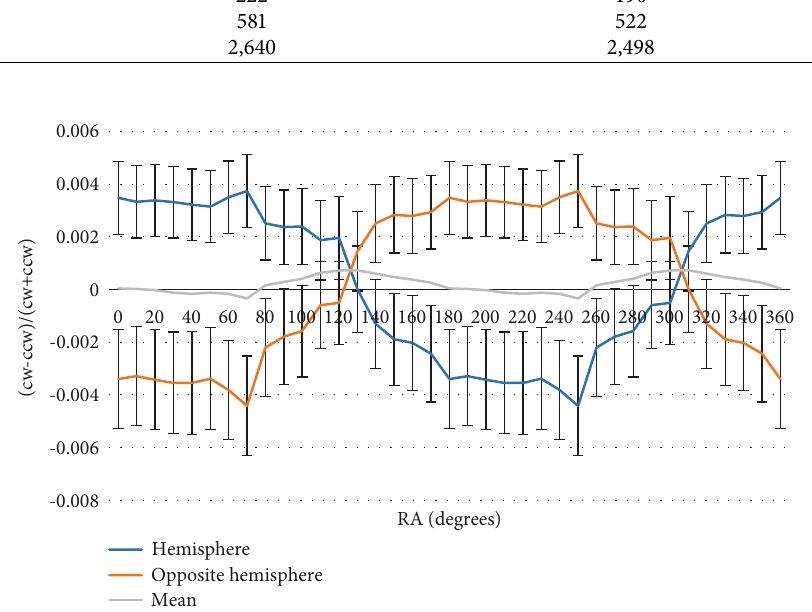
Figure 3: The asymmetry between the number of galaxies that spin clockwise and the number of galaxies that spin counterclockwise in hemispheres centered at different RAs. The blue line shows the asymmetry in the hemisphere centered at the RA of the x -axis, and the orange line shows the same measurement in the opposite hemisphere. The error bars are the normal distribution standard error of 1/ is the total number of galaxies in the hemisphere. The gray line shows the average of the asymmetry in both Table 8: Number of clockwise and counterclockwise galaxies in the hemisphere (130 ° , 310 ° ) and the opposite hemisphere ( < 130 ° ∪ > 310 ° ) . The P value shows the binomial probability to have such distribution by chance if a galaxy has a probability of 0.5 to be assigned to a certain spin direction.